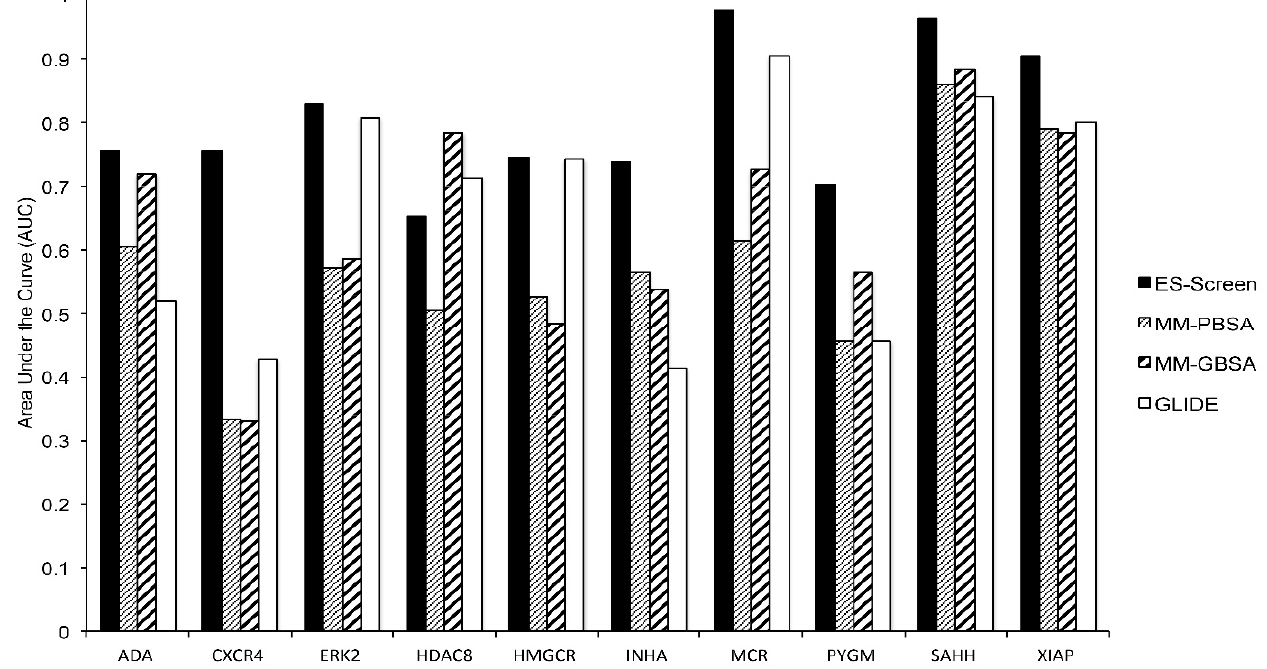
Figure 2. Areas under the curve for the DUD-E dataset determined from ROC curves in Figure 1 include MM-GBSA/PBSA methods.